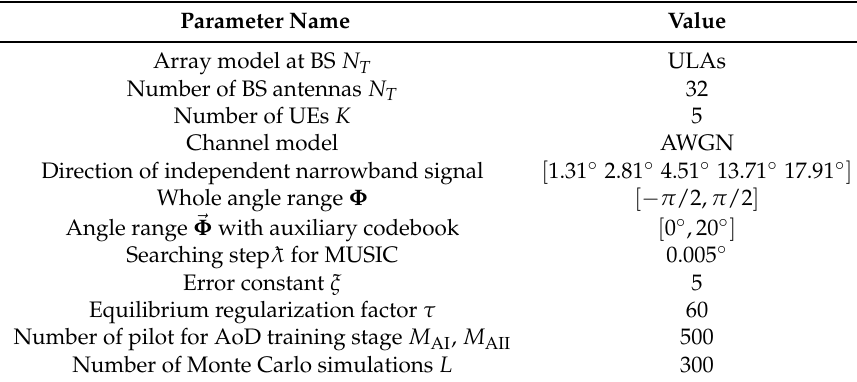
Table 1. Simulation parameters.